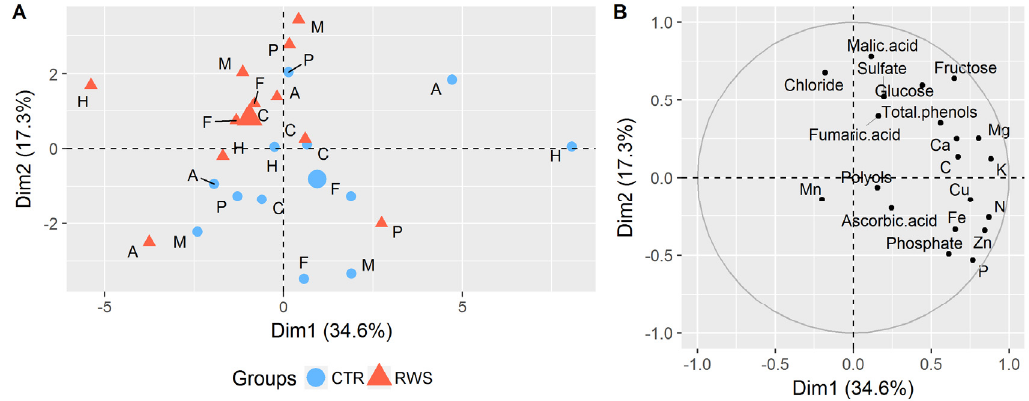
Figure 4. Multivariate evaluation by PCA (PC1 + PC2) of the cucumber dataset including both harvesting sets (week 28 and week 29) based on fresh matter-data. Score plot ( A ) represents all individual plot samples (marked by the letters A, C, F, H, M, and P) classified according to the control CTR (blue circles) and reduced water supply RWS (red triangles). The corresponding loading plot ( B ) shows the related variables, i.e., contents of constituents as determined by the chemical analyses.